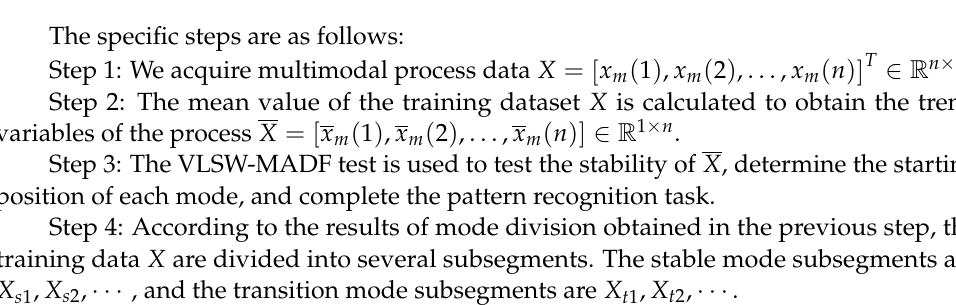
Figure 1. Illustration of the detailed steps of the VLSW-MADF